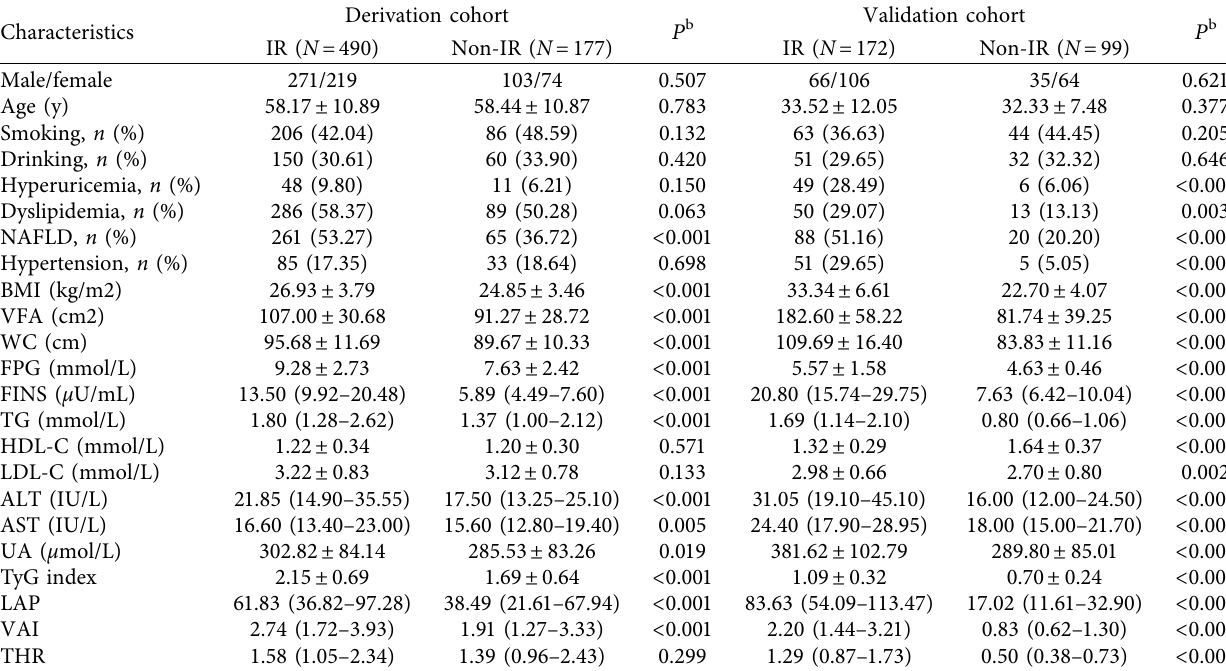
Table 1: Clinical characteristics of the two study cohorts.